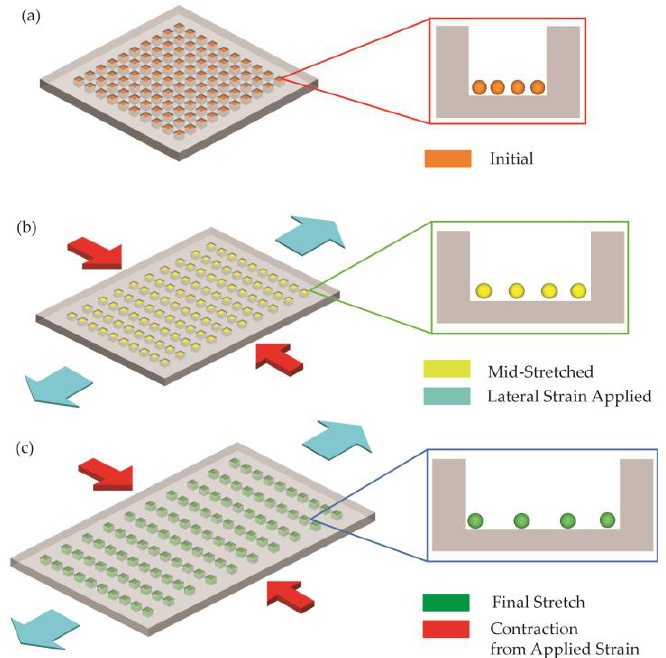
Figure 1. Illustration of the change in the reflected color of hierarchical dewetted Ag nanostruc- tures (Ag nanoislands formed in nanowells) on a stretchable substrate before ( a ) and after ( b , c ) be- ing stretched. The schematics indicate the Poisson contraction of the membrane in the direction or- thogonal to the applied strain.